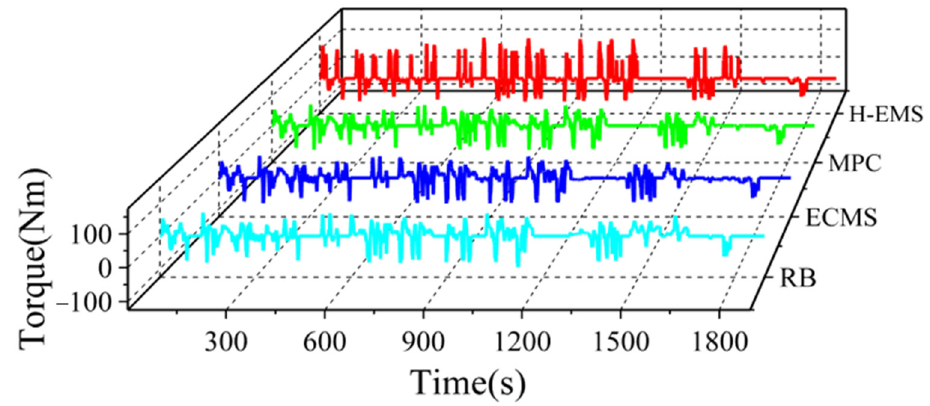
Figure 16. Rear motor torque of energy management strategies.